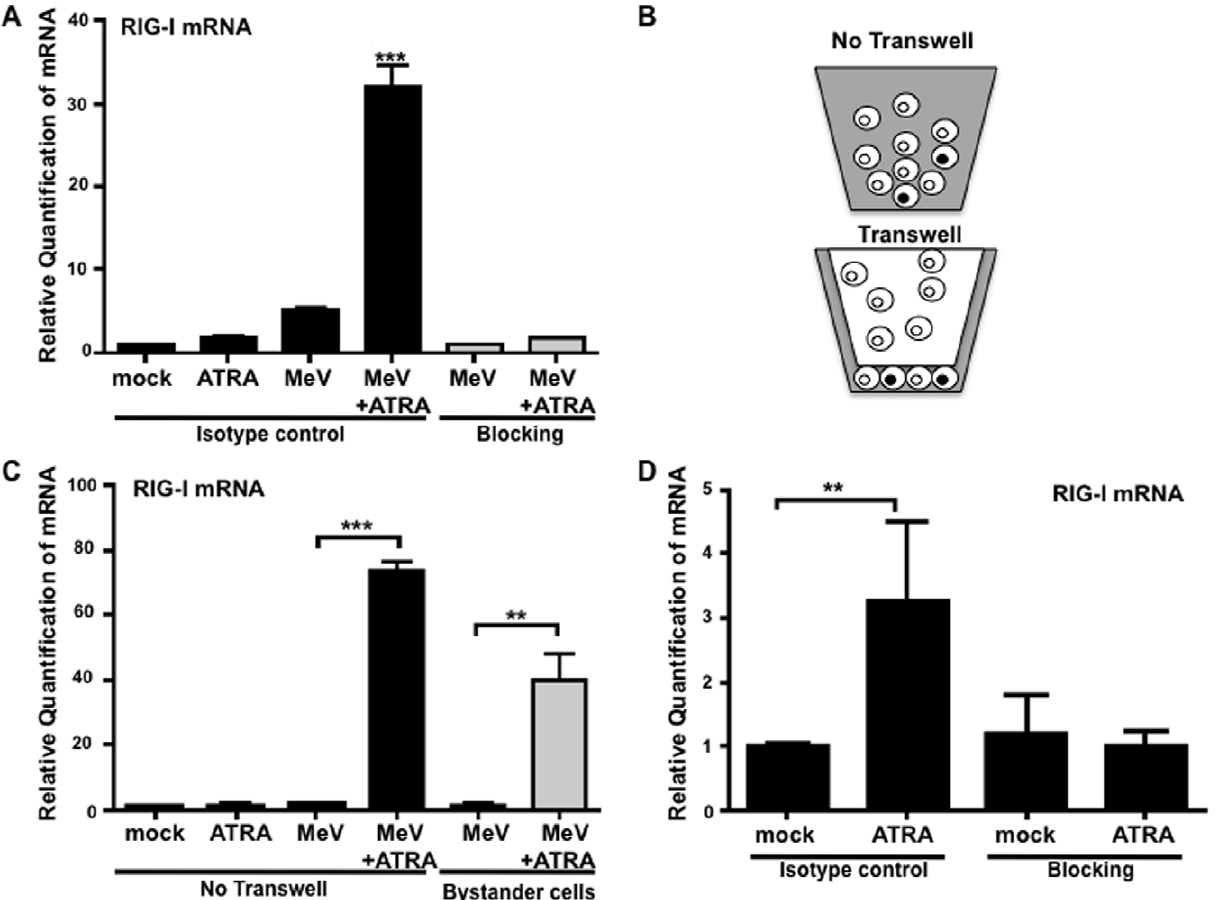
Figure 3. MeV with ATRA induces the soluble factor IFN to elicit the expression of RIG-I. (A) Cells were infected with MeV at an MOI of 0.1 in the presence of 1 m M ATRA or DMSO, and either IFN ab -receptor blocking antibodies or isotype control. RNA was extracted at 24 h and RIG-I expression was measured by qPCR. Data presented are representative of 2 experiments performed in triplicate (N=2). (B) Transwell membrane inserts with 0.02 m m pores were used to separate the infected cells from the uninfected, bystander cells in the inner chamber [9]. (C) Cells from transwell-free control wells and the inner chamber bystander cells were harvested after 48 hours and RIG-I mRNA was measured by qPCR. Data presented are representative of three experiments performed in triplicate (N=3). (D) Supernatants from the control wells and the inner chambers of the transwells were used to treat fresh U937 cells with either IFN ab -receptor blocking antibody or isotype control antibody. Following 24 hours of incubation, RIG-I expression was assessed by qPCR. Data presented are representative of three experiments performed in triplicate (N=3). **p , 0.01, ***p , 0.001.